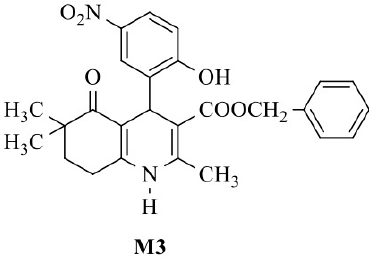
Figure 1. Molecular structure of M3.